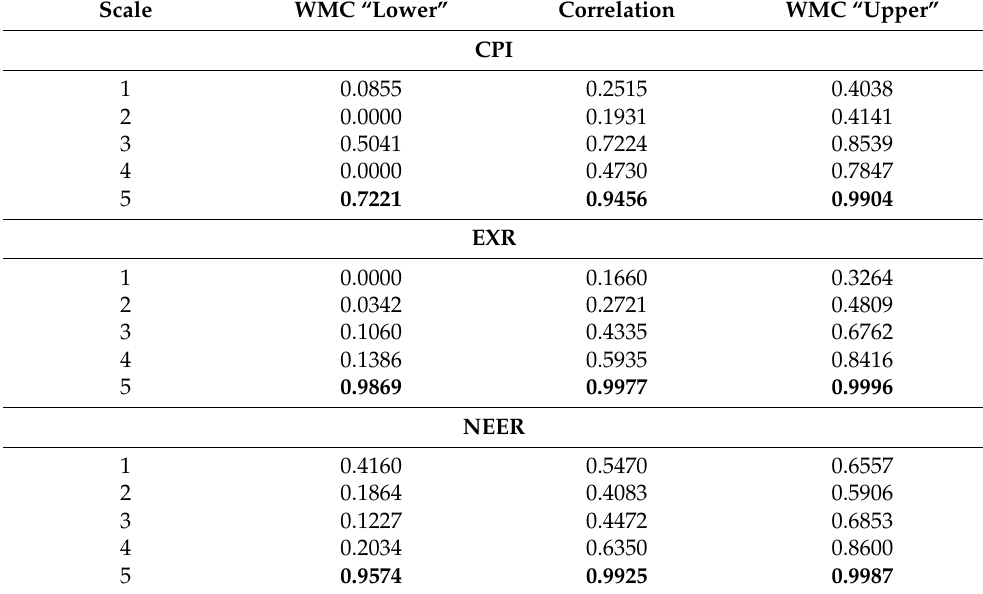
Table 2. Wavelet Multiple Correlations (WMC).